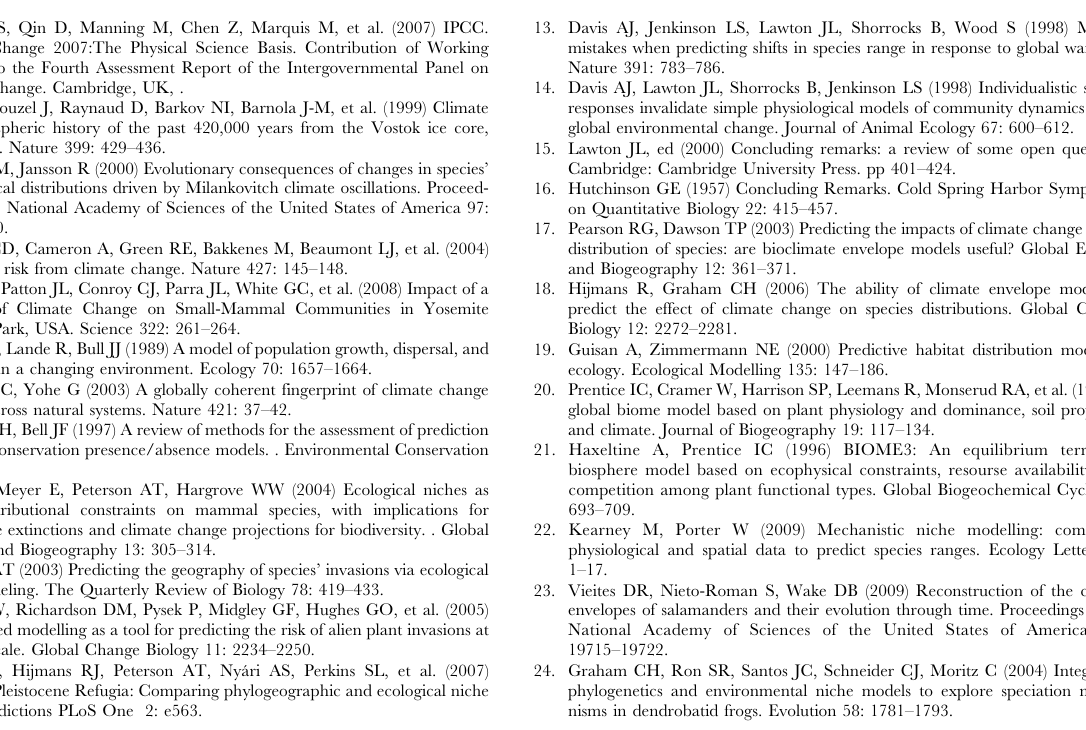
models to generate these maps. The dark gray curve represents the southern extent of glaciers during the LGM. B, Composite oxygen isotope curve for the last 320 ky inset with a yellow circle to indicate the oxygen isotope ratio and the time interval used in